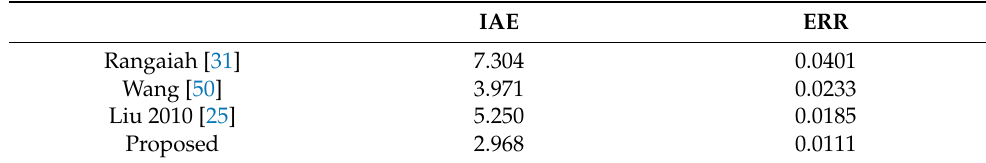
Figure 18. The Bode plots for process G P4 . Table 9. The criteria values for the process G P4